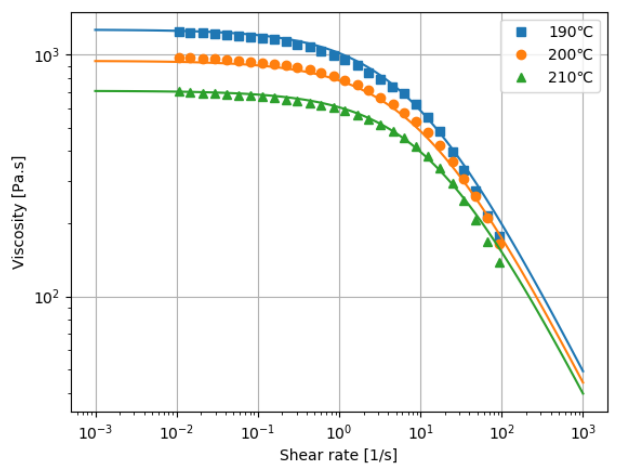
Figure 6. Viscosity data and curves for PP2.